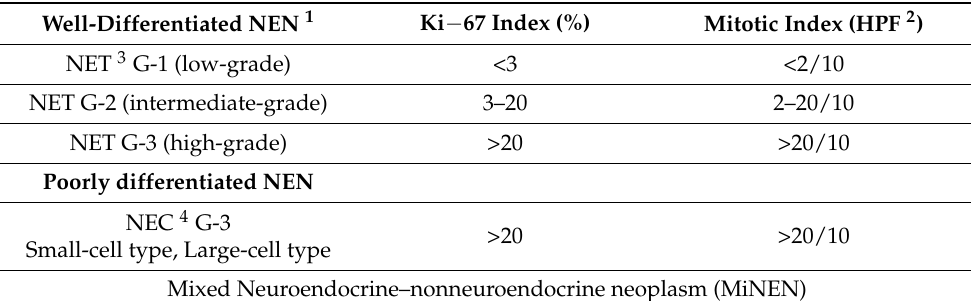
Table 1. The 2019 World Health Organization (WHO) classification for Neuroendocrine Neoplasms (NEN) of the digestive